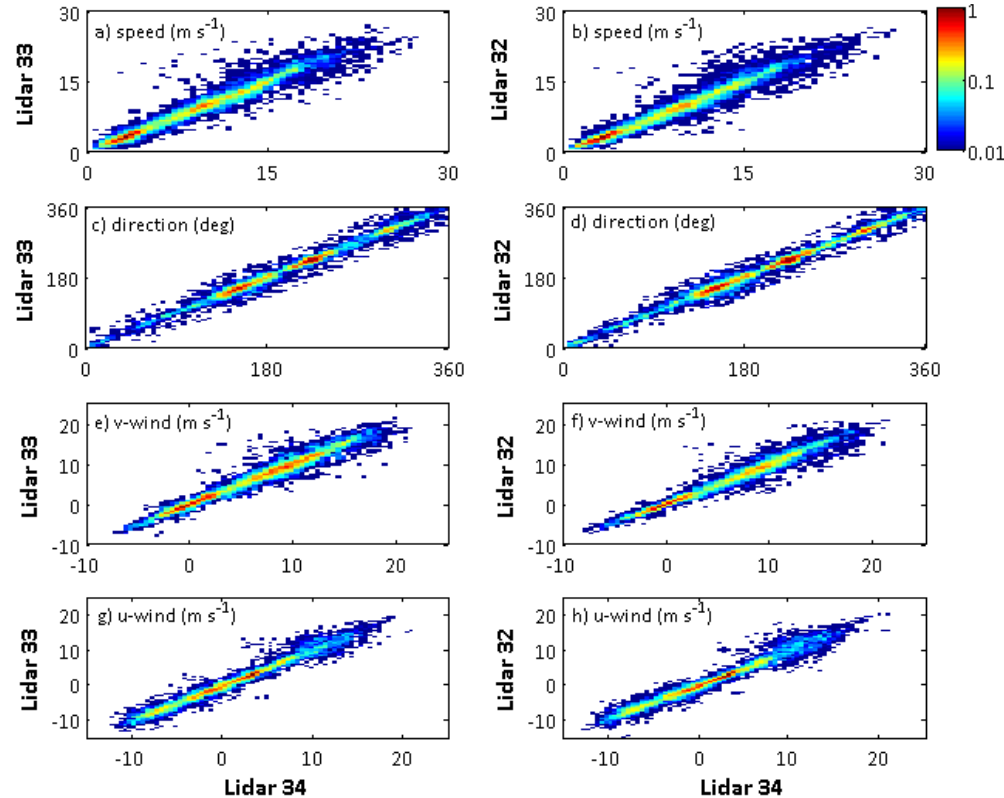
Fig. 7. Frequency of horizontal wind speed and direction, and v and u components of velocity measured during the first measurement campaign in Helsinki during the period 2–15 September 2011. Left panels show comparison of lidar 33 to lidar 34; right panels show comparison of lidars 32 and 34. Each point is an average over 15min and all available data between 150 and 1050m are shown. Pixel width for velocity and speed was 0.5ms − 1 , and for direction 5 ◦